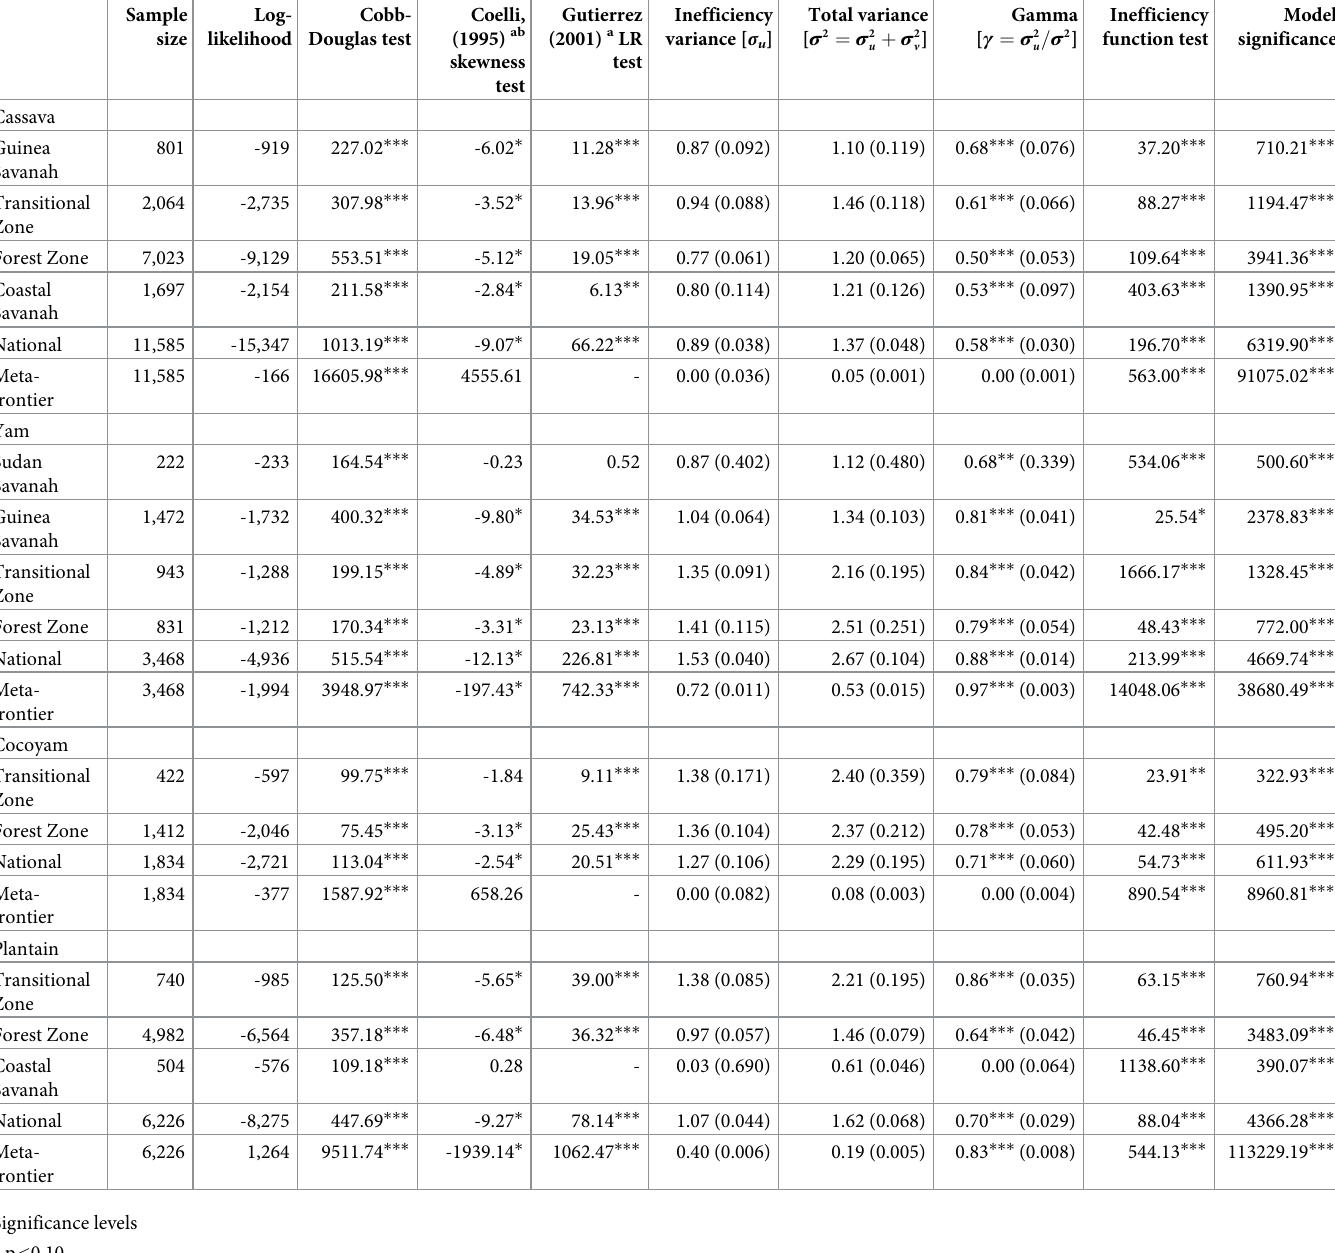
Table 2. Hypothesis tests for ecology- and meta-frontier models for starchy staple production in Ghana (1987–2017). Sample